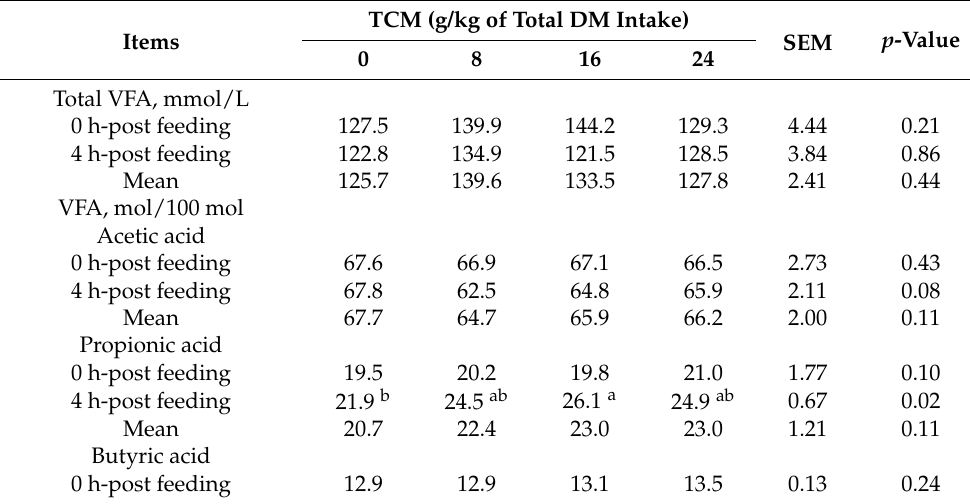
Table 4. Effect of supplementing meals with Terminalia chebula meal (TCM) on ruminal volatile fatty acid